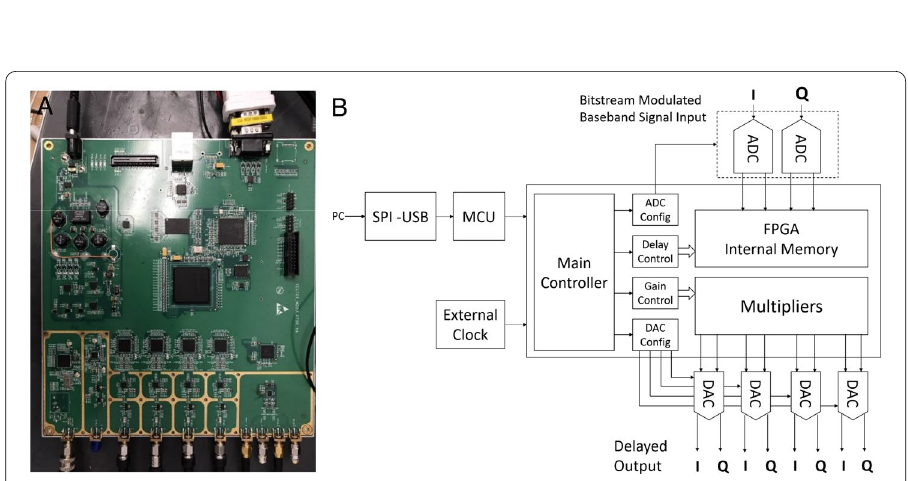
Fig. 14 Picture of the FPGA board which controls the delay of each channel. a Picture of the FPGA board. b FPGA function